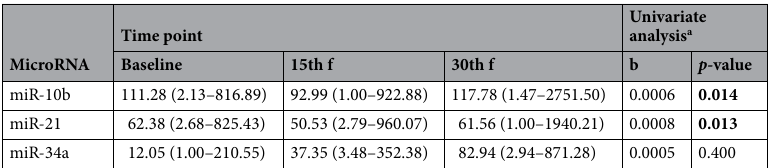
Table 2. Univariate analysis-miR-10b/21/34a and toxicity grade. p values equal or less than 0.05 are significant (bold). a Univariate ordinal regression models with the degree of toxicity as dependent variable. Median values of microRNA expression values with min–max ranges in parentheses were presented for each time point-at baseline, 15th fraction (15th f) and 30th fraction (30th f).